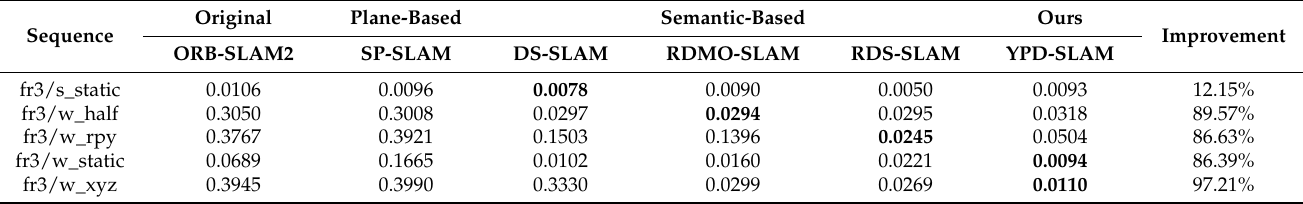
Table 2. Experimental RMSE results of translational relative pose error (RPE). Our method is YPD- SLAM, and Improvement stands for comparison with the original algorithm